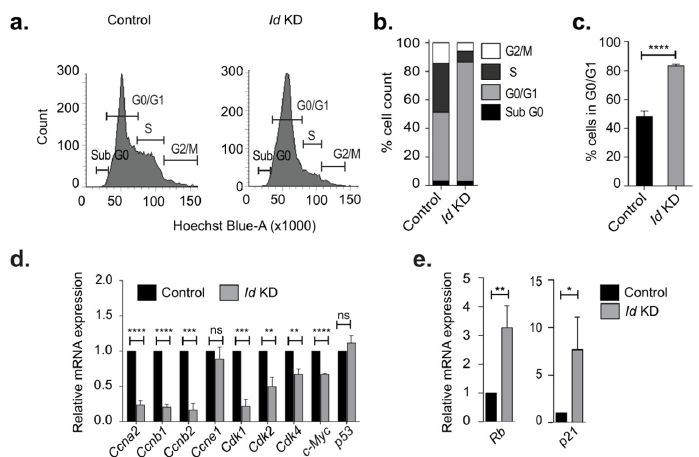
Figure 1. Effect of inhibitor of differentiation ( Id ) knockdown on cell cycle genes. ( a ) Flow cytometric analysis of cell cycle on control and Id knockdown (KD) cells after labelling with Hoechst 33342 stain. ( b ) Comparing the percentage cell count in each phase of the cell cycle, showing a significant increase in the G0 / G1 phase in Id KD conditions. ( c ) Percentage cell count in G0 / G1 phase of control and Id KD cells. ( d ) The relative mRNA expression level of cell cycle genes Cyclin A2, B1, B2, E1 ( Ccna2 , Ccnb1 , Ccnb2, Ccne1 ), Cyclin dependent kinase 1, 2, 4 ( Cdk1 , Cdk2 , Cdk4 ), c-Myc , and p53 in control